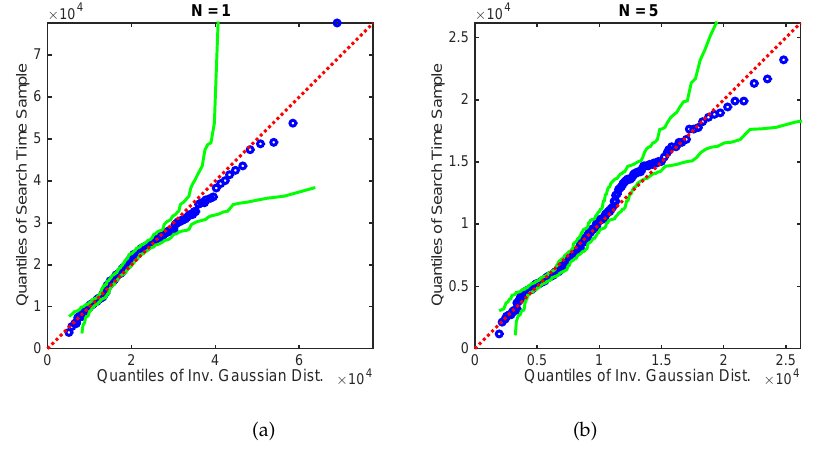
Figure 8. Experimental data: Q-Q plot of the search times for ( a ) N = 1 and ( b ) N = 5 versus the inverse Gaussian distribution with parameters fitted using maximum likelihood estimation. The source was placed as shown in Figure 7 and initial centroid position was fixed at [ 125, − 125 ] . The green lines show 95% confidence bands